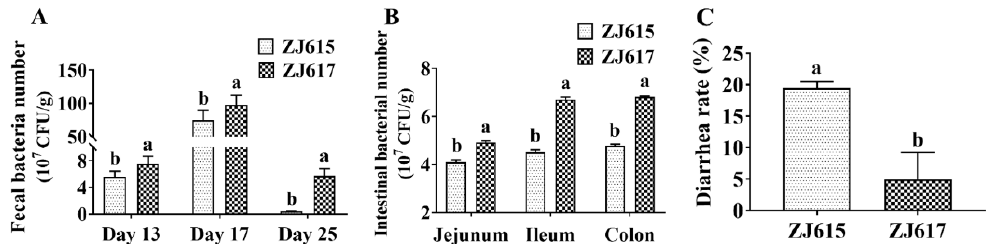
Figure 7. Adhesion of L. reuteri ZJ617 and ZJ615 in the porcine intestine. The number of lactobacilli in discharged feces and homogenized intestinal segments was determined by serial dilution on agar plates in the presence of streptomycin. ( A ) Number of bacteria in fecal samples. Feces were collected on days 13, 17, and 25. ( B ) Number of bacteria in the intestine after piglets were sacrificed at 25 days. ( C ) Diarrheal rate, calculated as the product of the number and times of diarrhea piglets divided by the product of the number of piglets raised and days in the experimental period. A one-way ANOVA with Duncan’s multiple range test was used ( n = 6). Di ff erent letters indicate significant di ff erences between the two strains ( p < 0.05).